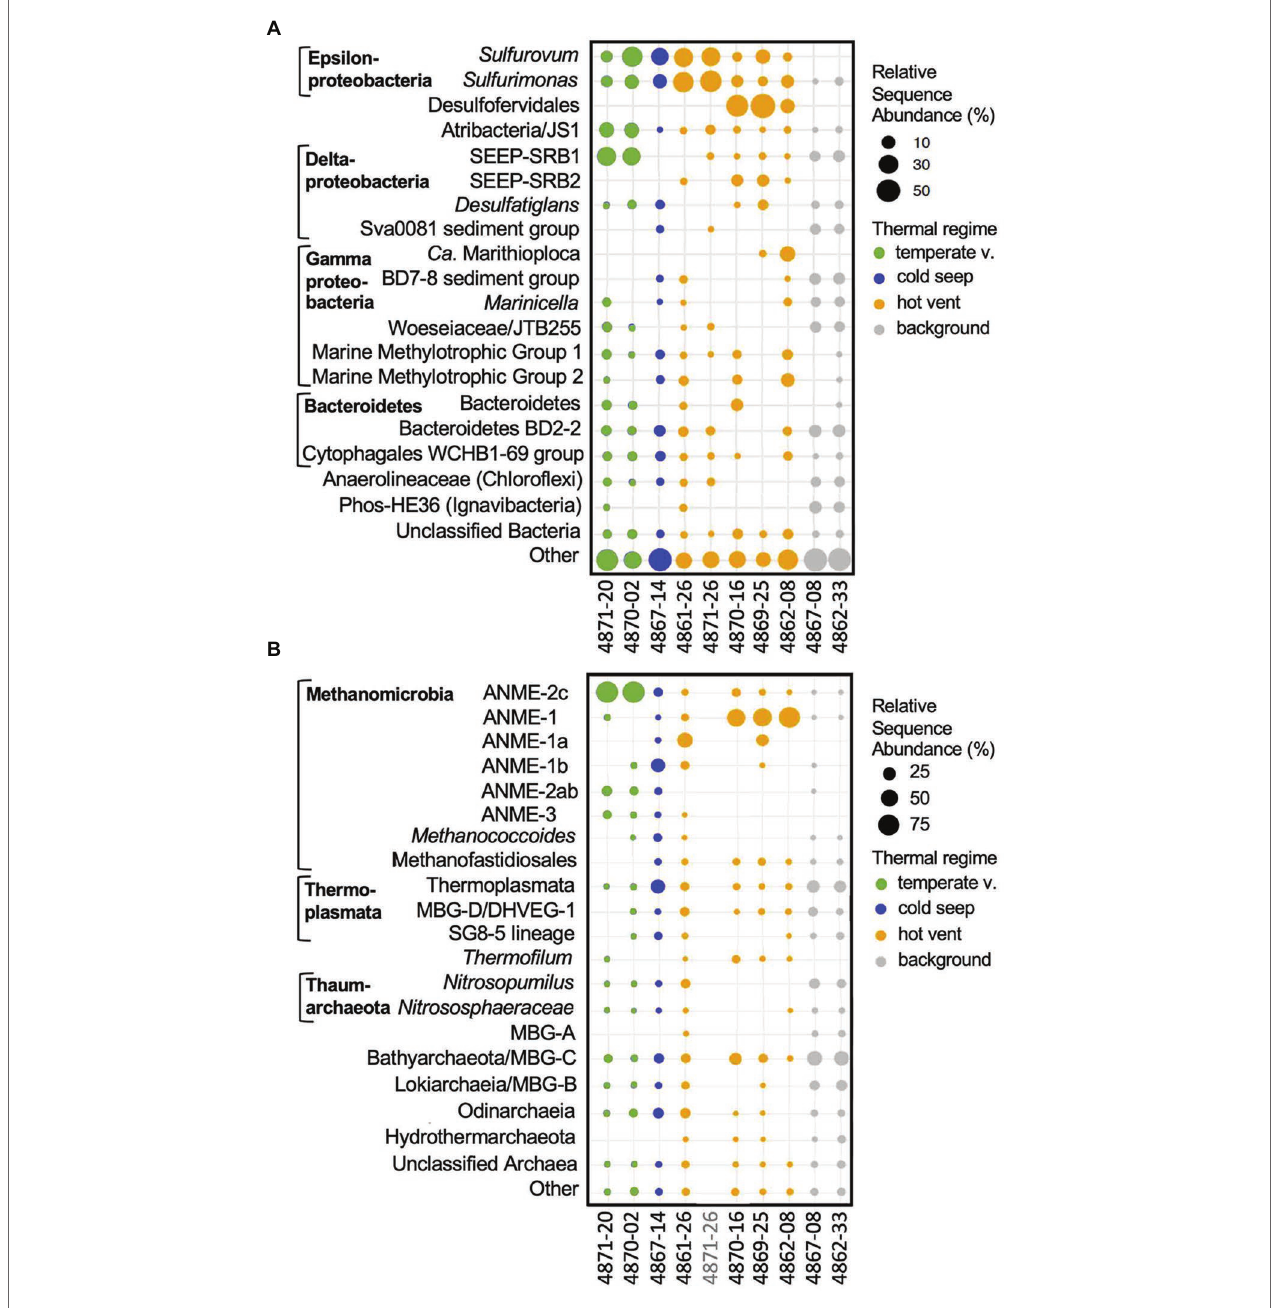
FIGURE 7 | Bacterial and archaeal community composition of Guaymas Basin sediment cores. The size of the dots indicates the relative sequence abundance of microbial clades based on 16S rRNA gene amplicon sequences. The 20 most abundant bacterial (A) and archaeal (B) family-level lineages are shown. Less abundant clades are summarized as “Other.” When appropriate, taxa are annotated to supplement the automated SILVA identifications. DNA from core 4871-26 had run out after several sequencing attempts before archaeal sequencing could be